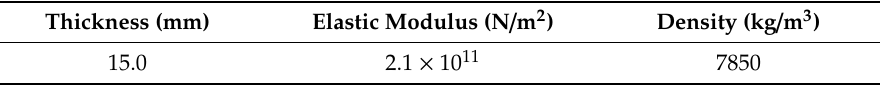
Table 4. The property of model.